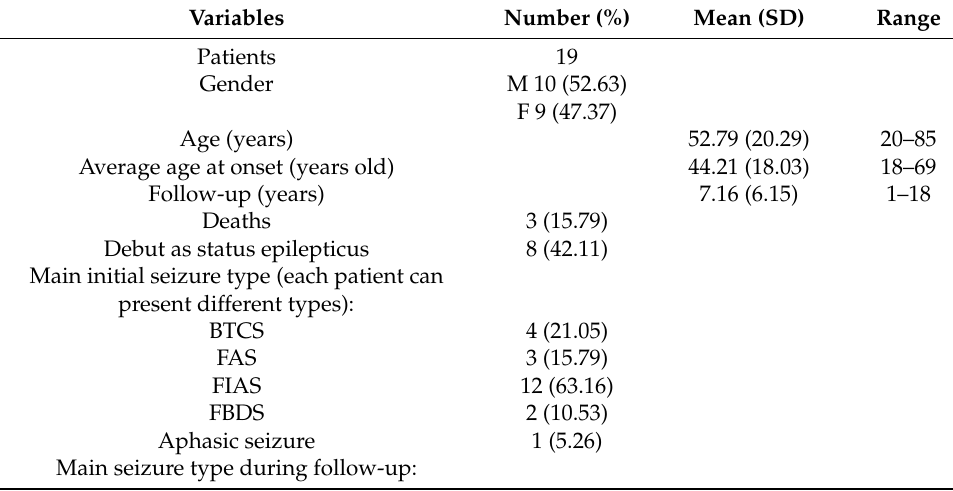
Table 1. Clinical and demographic characteristics of the study